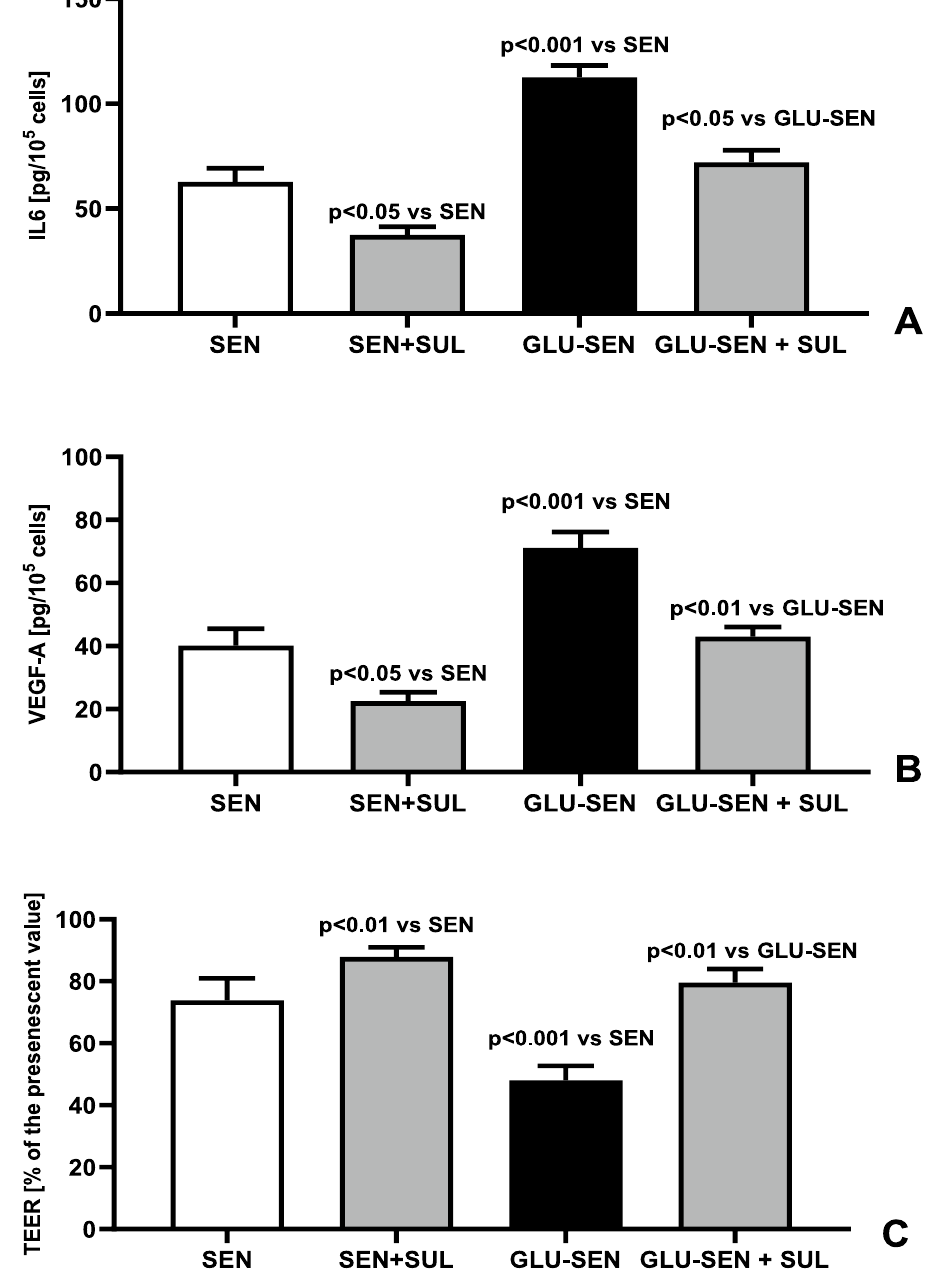
Figure 5. Effect of Sulodexide on synthesis of IL6 ( A ), VEGF ( B ) and value of TEER ( C ) in HREC made senescent in control medium (SEN)and in HREC made senescent in control medium + glucose 20 mmol/L (GLU-SEN) (n = 10) (ANOVA